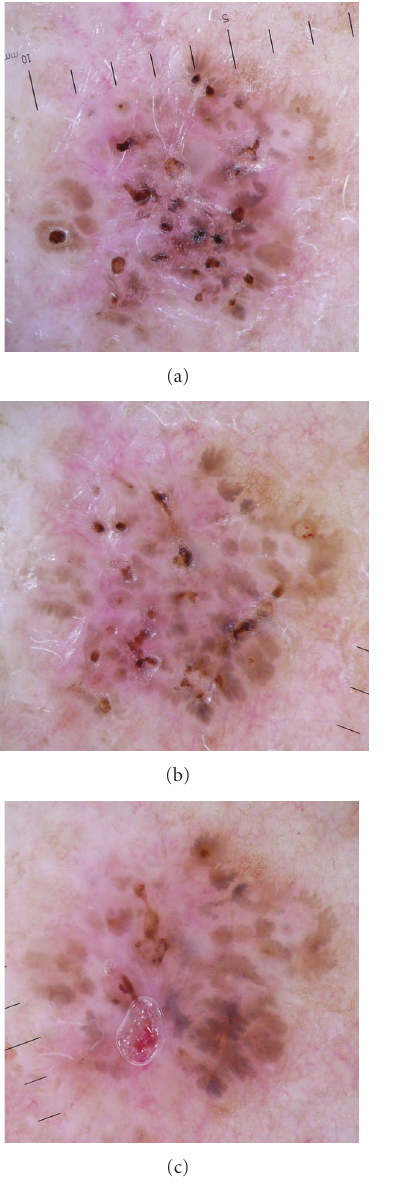
Figure 2: (a) Initial appearance under Heine 20 dermoscopy. (b) Dermoscopic examination 6 weeks later, before biopsy. (c) Dermo- scopic examination 8 weeks later, after biopsy stitch